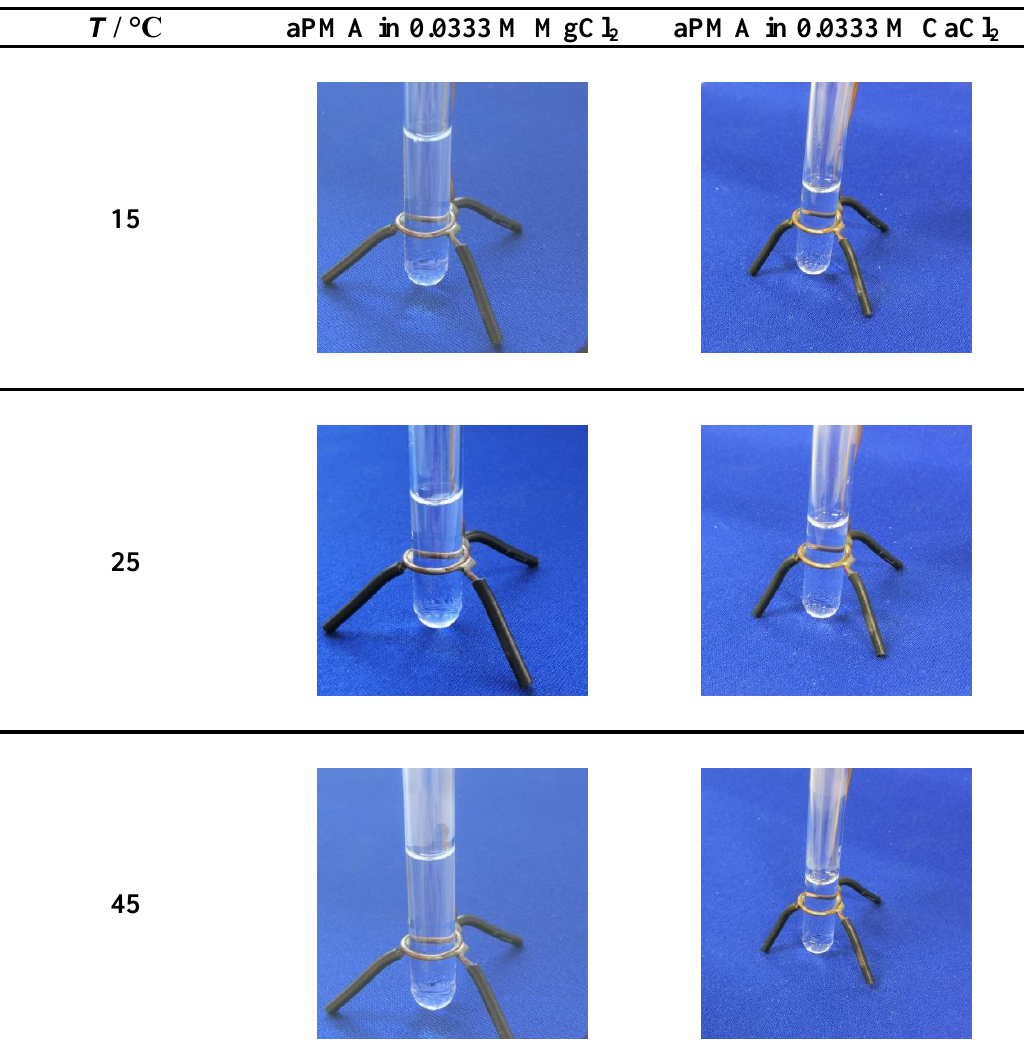
Table S2. Visual observations of aPMA ( c during heating in a water bath. For taking photos, samples were briefly taken from the water bath and photographed